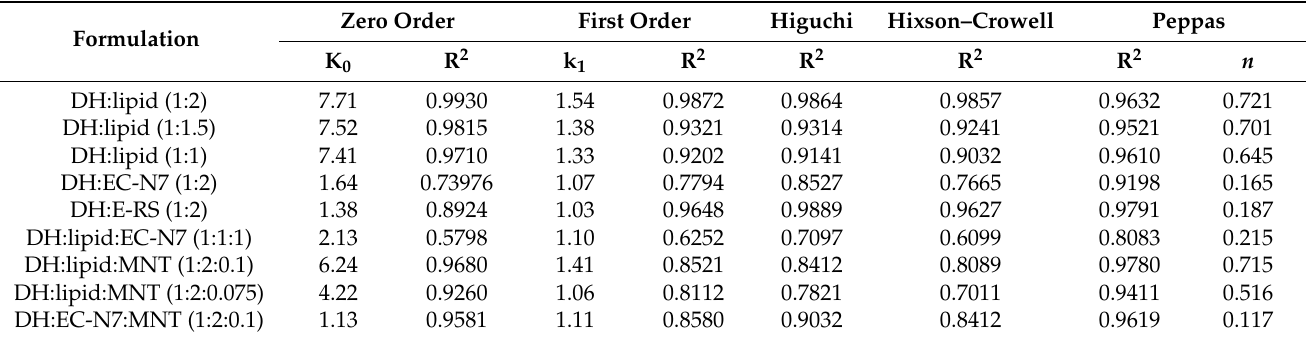
Table 7. Drug release kinetic parameters for drug release of DH from different extrudates. Zero Formulation